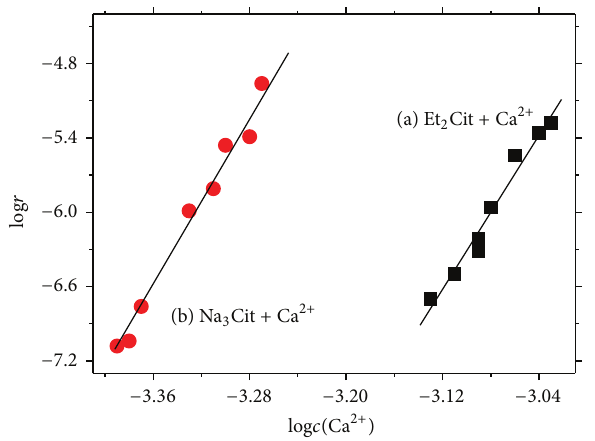
Figure 2: Plots of log 𝑟 -log 𝑐 (Ca 2+ ) in different systems: (a) Et 2 Cit- Ca 2+ system and (b) Na 3 Cit-Ca 2+